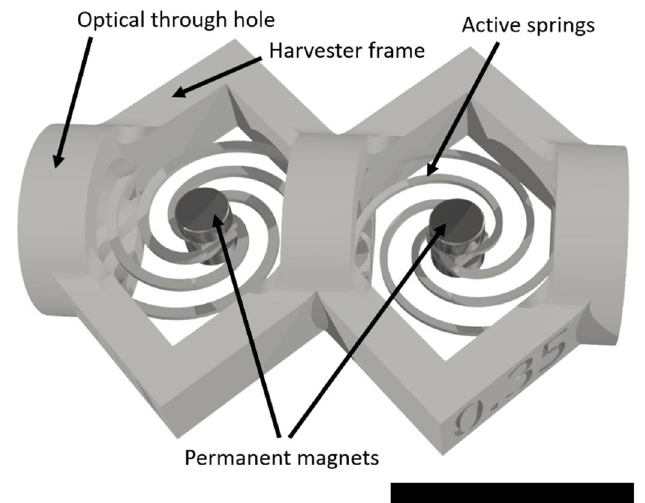
Figure 5. Computer visualization of the harvester with two independent vibrating structures with magnets (scale bar 10 mm). Source of figure ([42] CCBY).